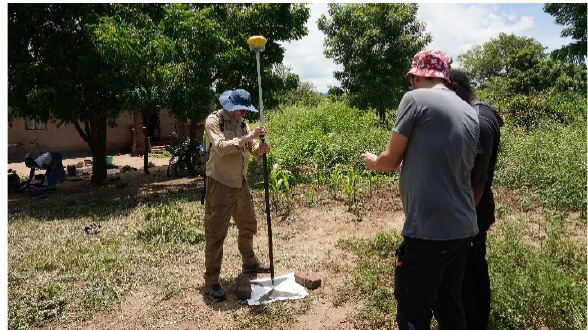
Figure 4. GCPs measurements in Nsanje